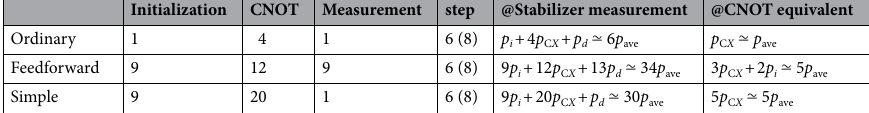
Table 2. Number of operations in one round of stabilizer measurements, and error rate. The bracket in the “step” column indicates the X -stabilizer case. The right-most column indicates the error rate regarding data qubits at one equivalent